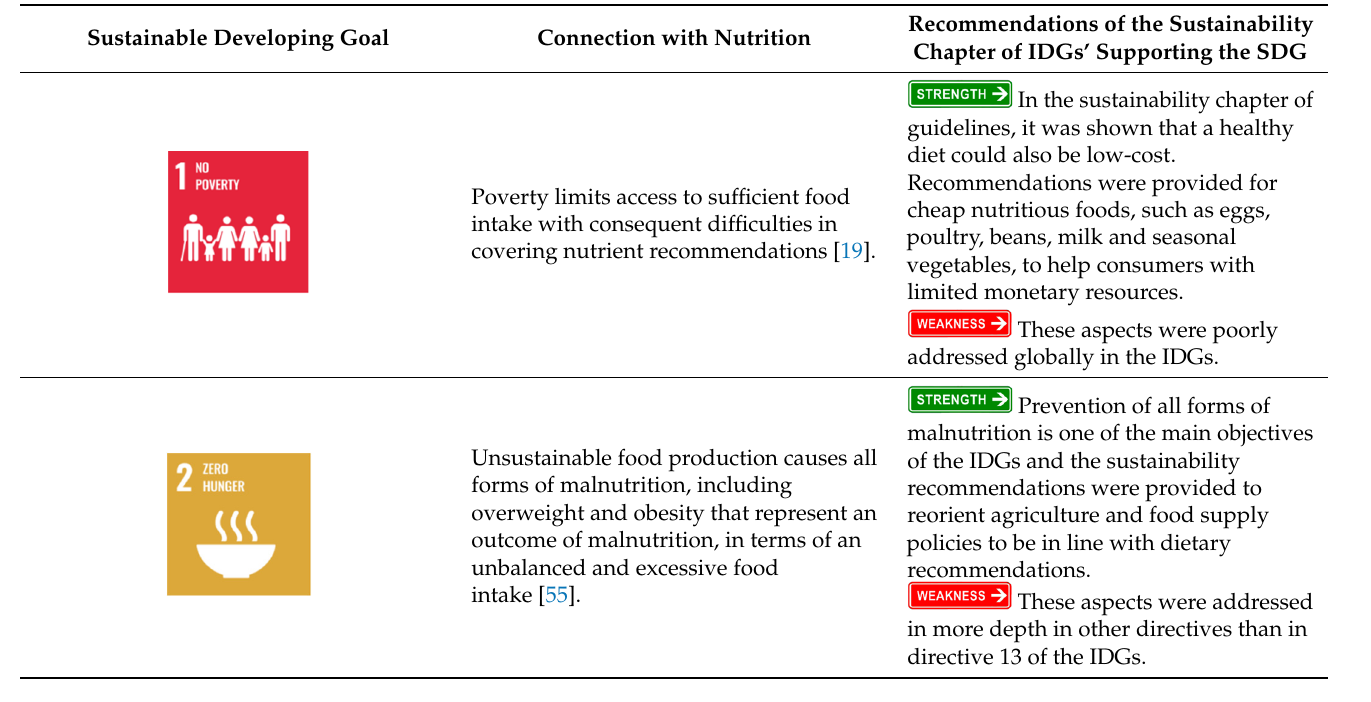
Table 2. Policies and recommendations of the IDGs’ sustainability chapter contributing to SDGs’ achievements.